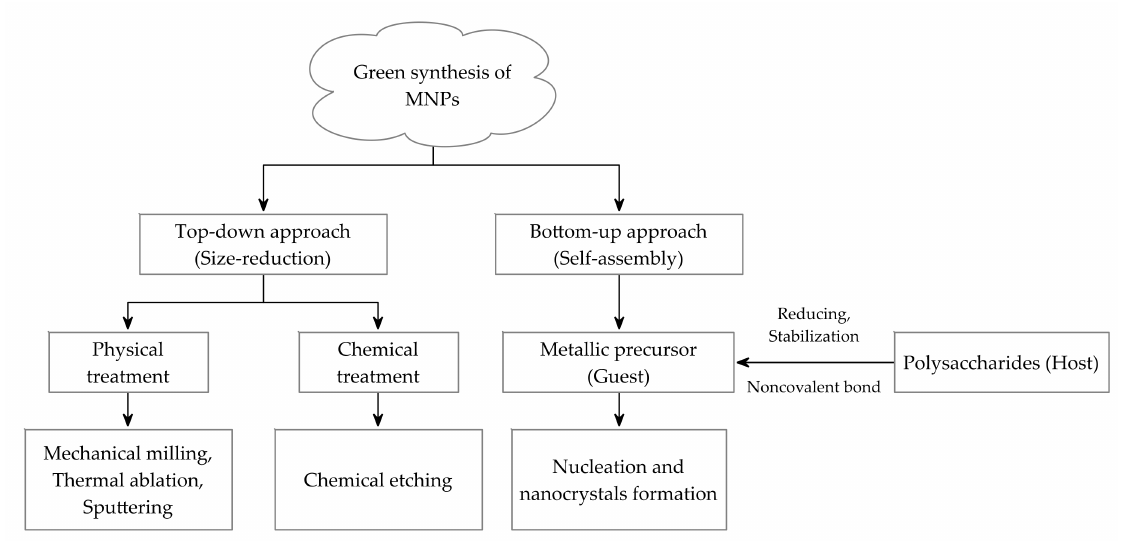
Figure 2. Overall approaches for the synthesis of